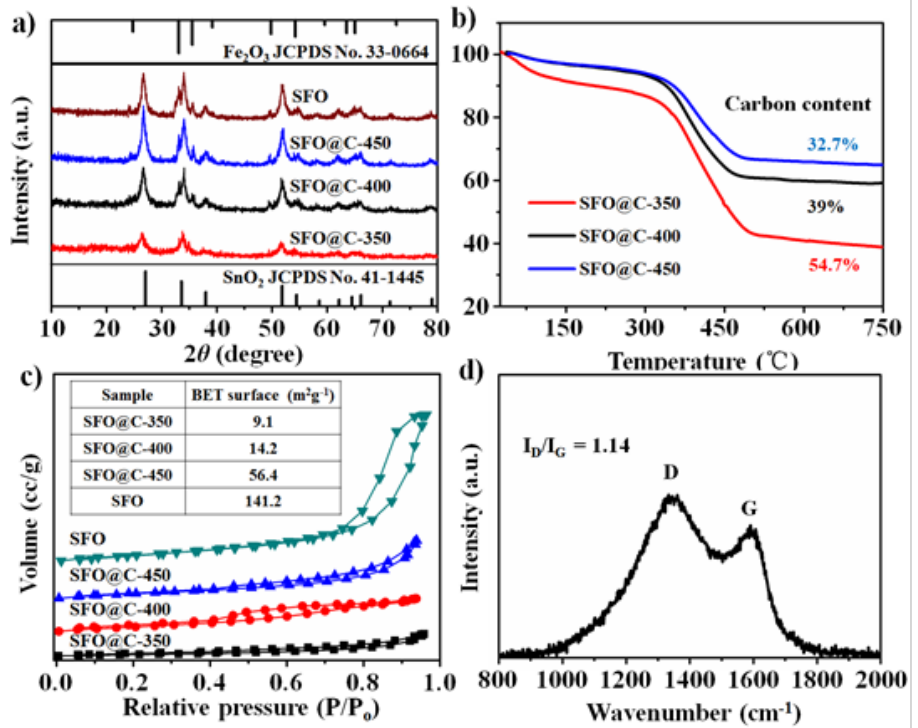
Figure 1. ( a ) XRD patterns; ( b ) N 2 adsorption / desorption isotherm curves, and TGA curves ( c ) of all Figure 1. (a) XRD patterns; (b) N 2 adsorption/desorption isotherm curves, and TGA curves (c) of all 252 samples; ( d ) Raman spectra of SFO@C-400 samples; (d) Raman spectra of SFO@C-400 sample. 253